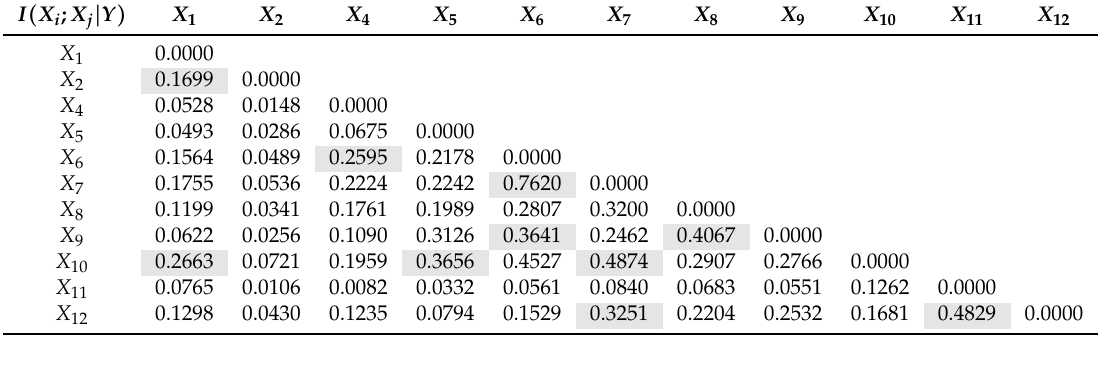
Table 3. The CMI matrix of deciding factors to learning attitude of L-students.